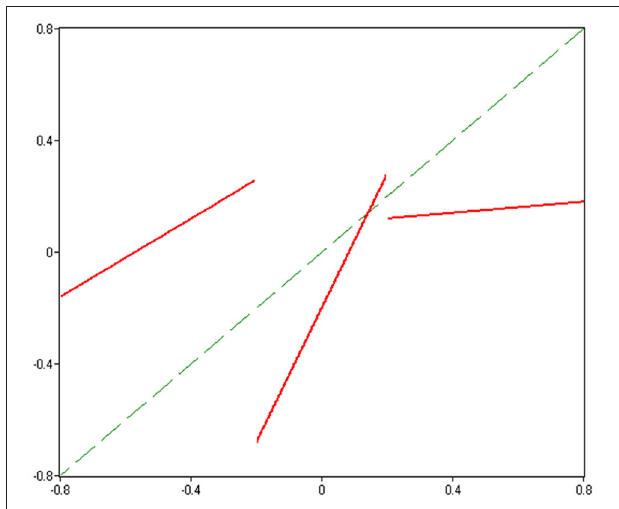
FIGURE 4 | The shape of the map is obtained by using m 1 = − 0.2, m 3 = 0.3, m 4 = 0.6, s 1 = 1.4, s 3 = − 2.3, s 4 = − 1.7, and z = 0.2.